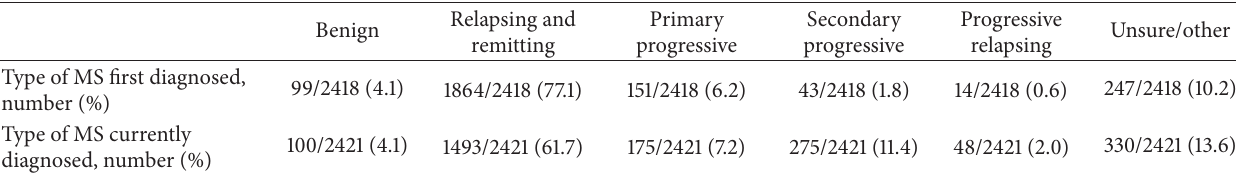
Table 5: Diagnosed subtype of MS.